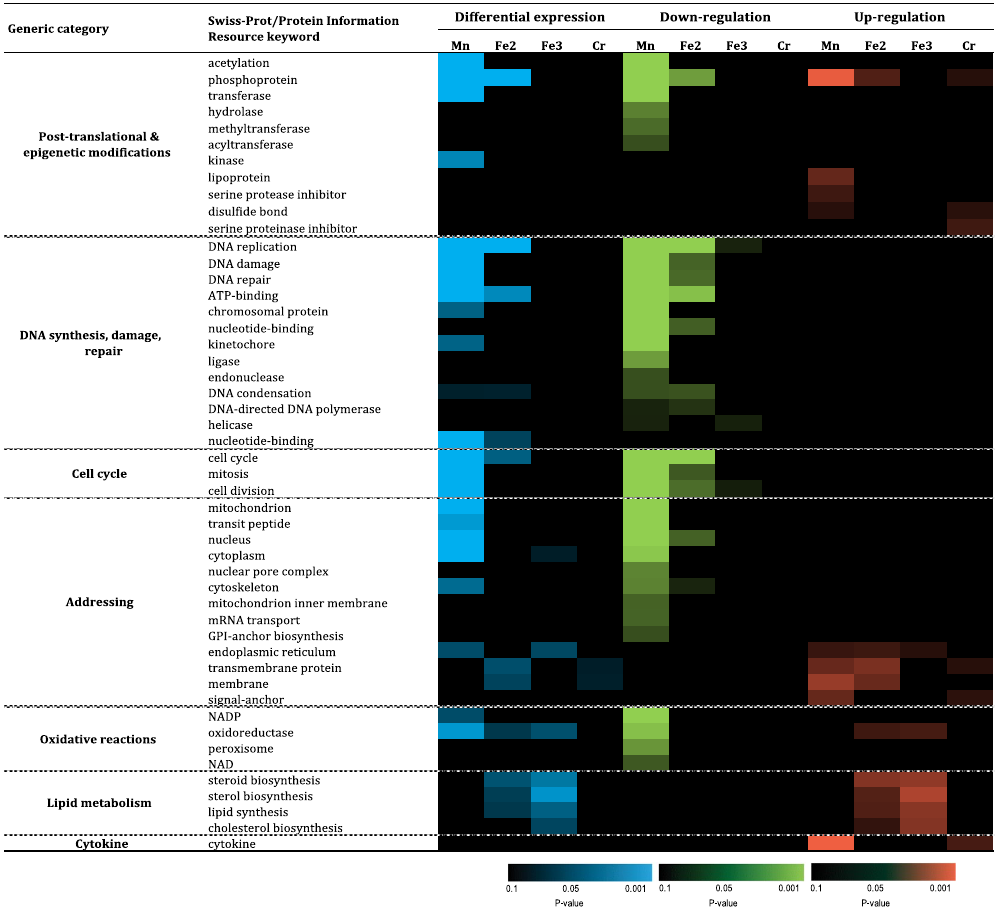
Figure 5. Functional enrichment of significantly regulated genes: Swiss-Prot/Protein Information Resource keywords. Abbreviations as in Fig.